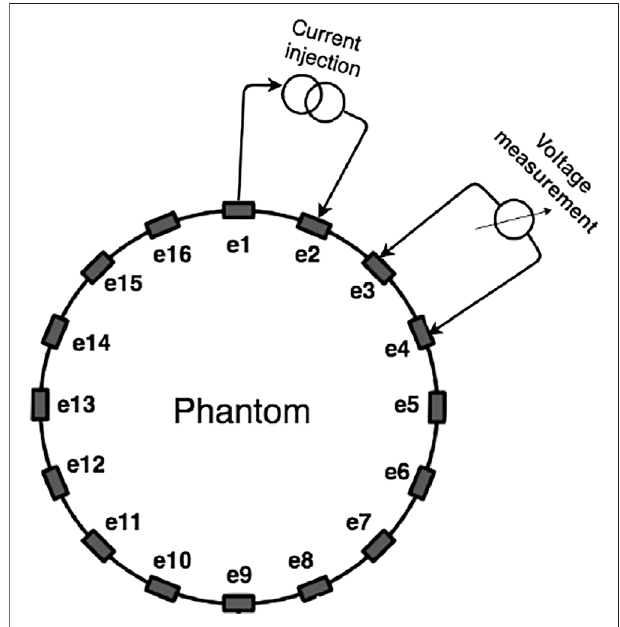
FIGURE 3 | Connections made for hand-selected electrodes